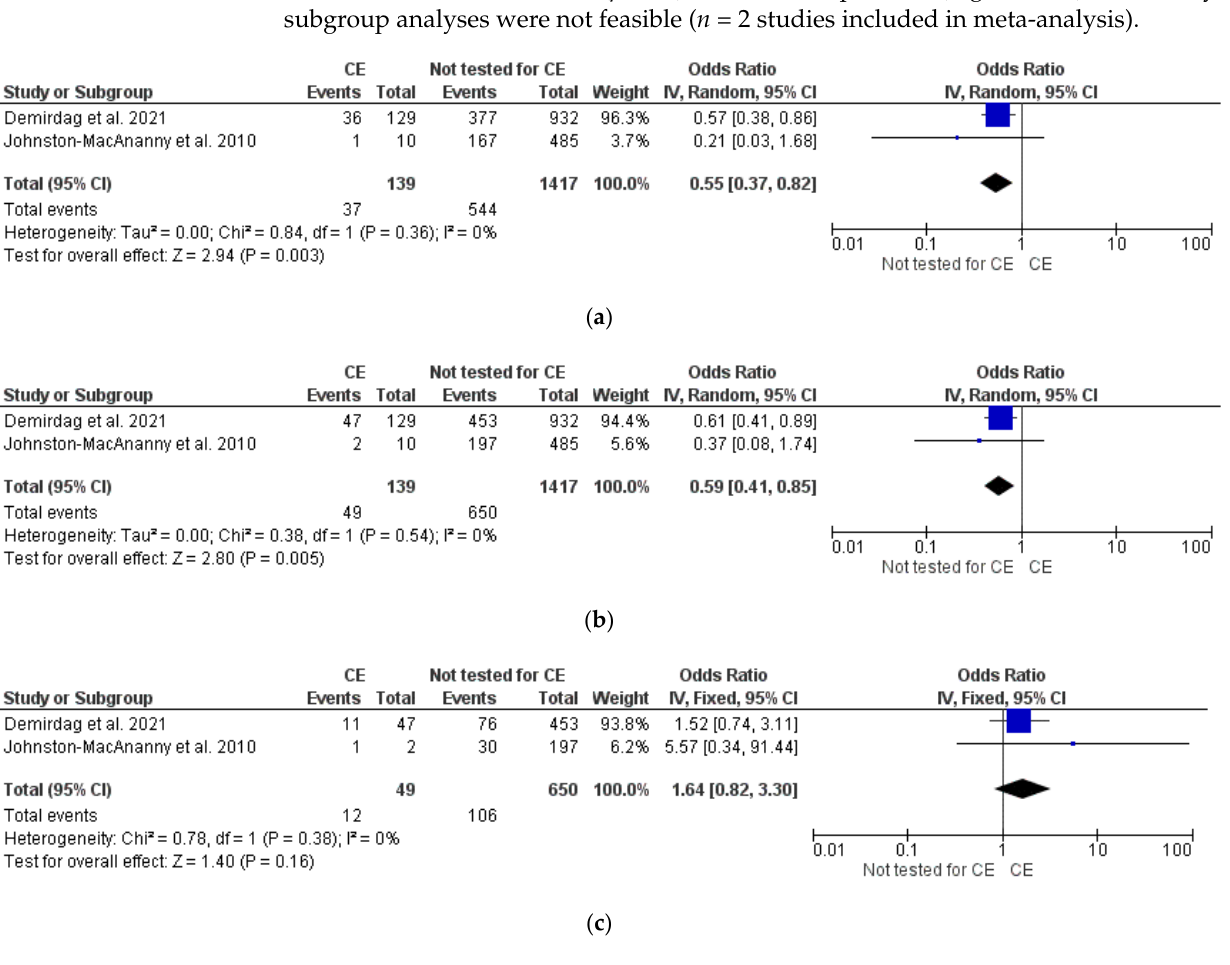
Figure 5. Pooled data analysis comparing CE versus non-tested for CE: ( a ) ongoing pregnancy rate/live birth rate; ( b ) clinical pregnancy rate; ( c ) miscarriage rate [6,11].